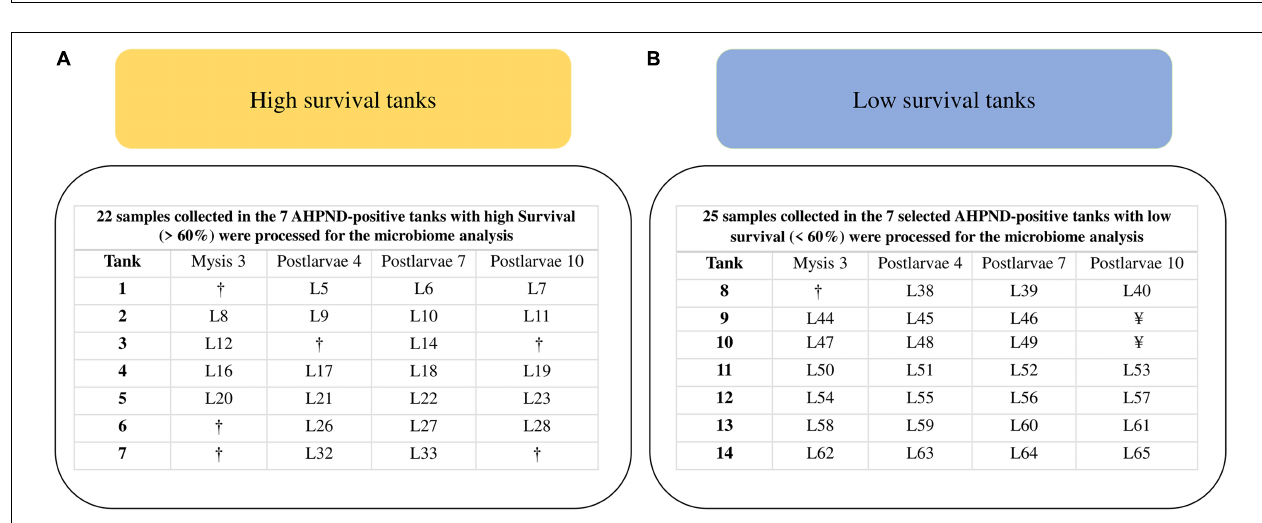
FIGURE 2 | Samples selected for the microbiome characterization of P. vannamei larvae affected by AHPND. (A) High-survival tanks. (B) Low-survival tanks. † Sample did not pass the DNA quality control. (cid:85) Sample not collected as the tank population died at PL9.